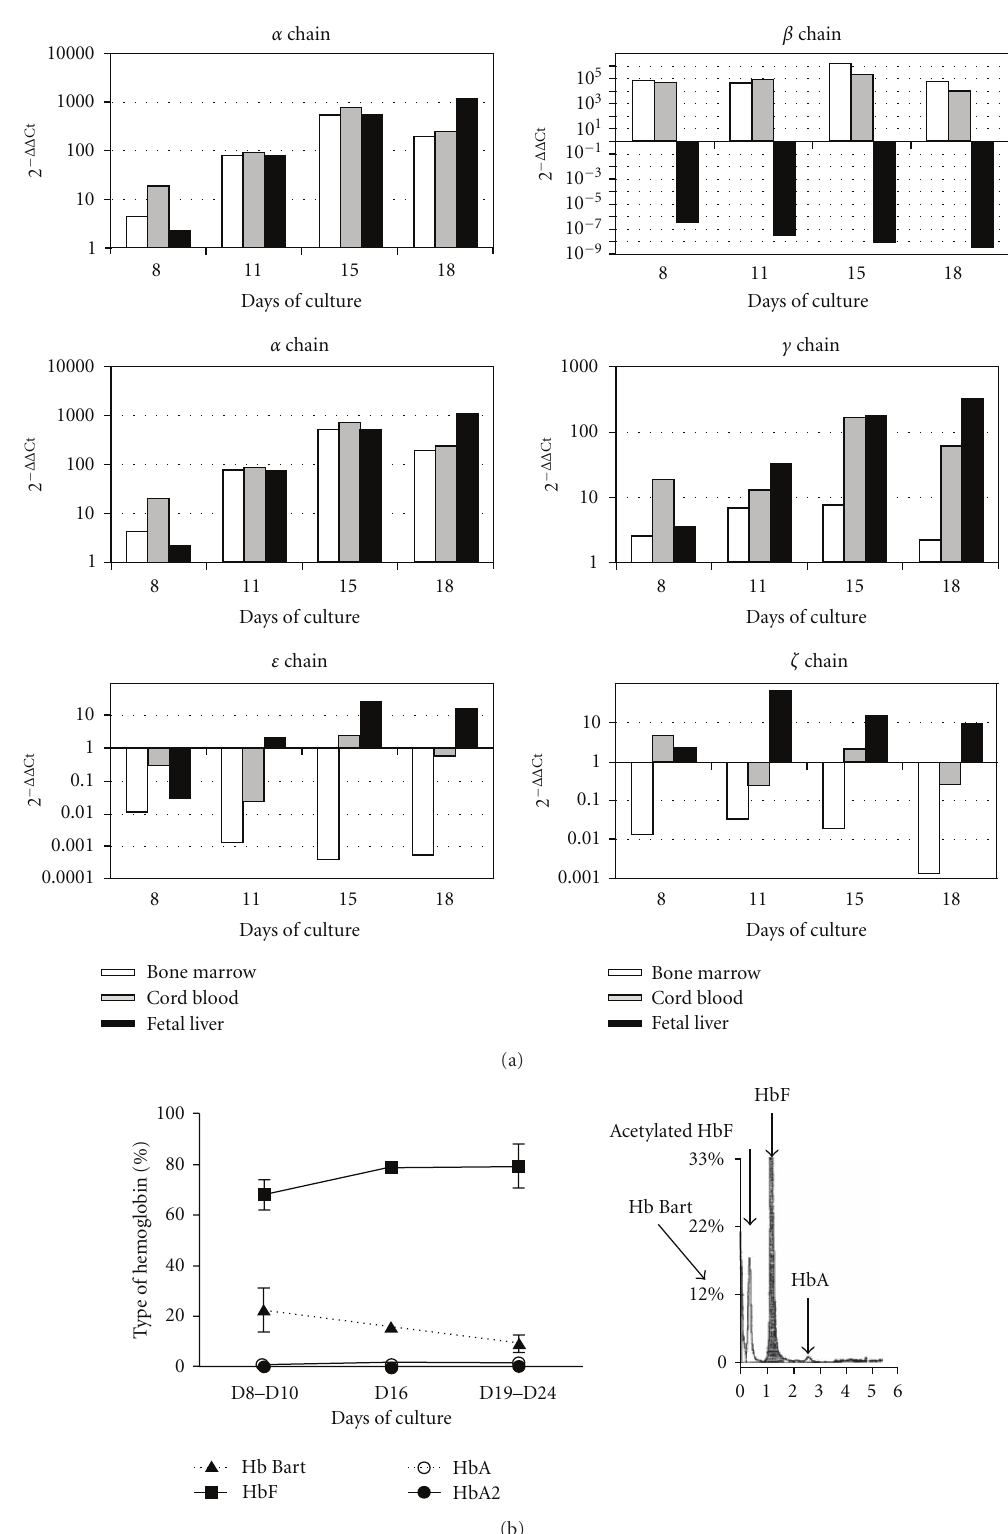
Figure 4: Analysis of the hemoglobin produced by FL-derived erythroid cells. (a) Quantitative real-time PCR analysis of the globin chains at di ff erent times of culture (days 8, 11, 15, and 18). Relative gene expression is given by the 2 − ΔΔ Ct method where ΔΔ Ct represents the di ff erence of an unknown sample (days 8, 11, 15, and 18 of culture) versus a control (day 0 of culture) for a target gene (globin genes) normalized to a control gene (18S). (b) HPLC analysis of the hemoglobin (Hb) produced on days 8 ( n = 6), 16 ( n = 2), and 19–24 ( n = 5) of erythroid di ff erentiation. Graph and profile show mainly fetal hemoglobin (HbF) including an acetylated